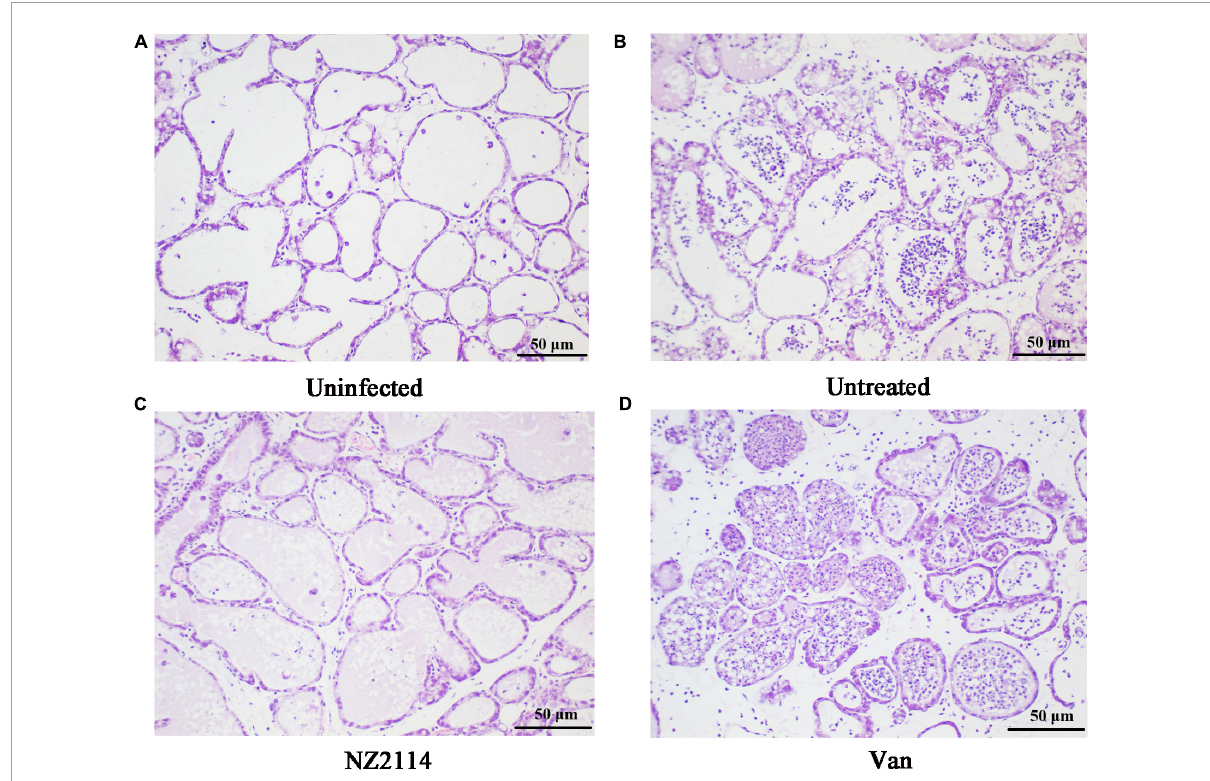
FIGURE7 Histological evaluation of breast tissues. (A) Uninfected group; (B) Infected and untreated group; (C) NZ2114 treated group; (D) Vancomycin treated